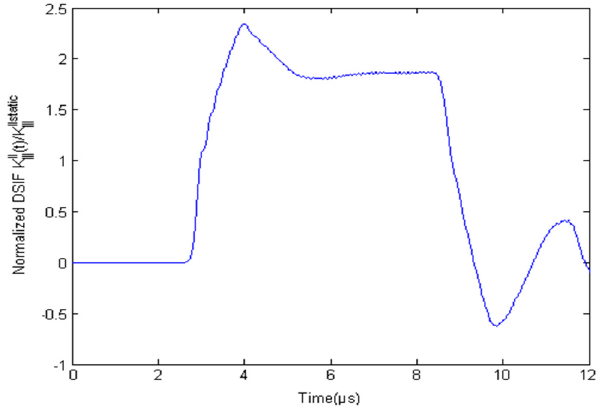
Figure 15. Normalized dynamic stress intensity factor versus time.